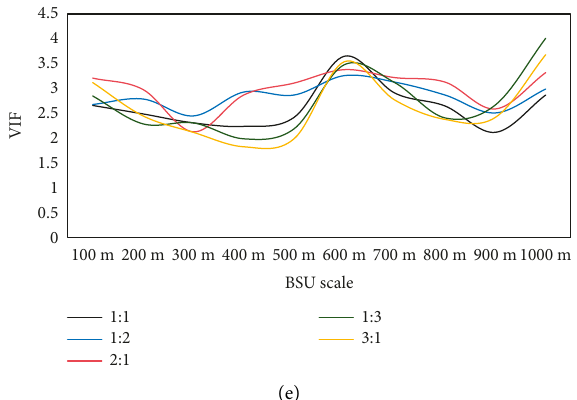
Figure 12: VIF of variables. (a) VIF of Population density. (b) VIF of HHI. (c) VIF of Intersection density. (d) VIF of Distance to CBD. (e) VIF of bus station density.